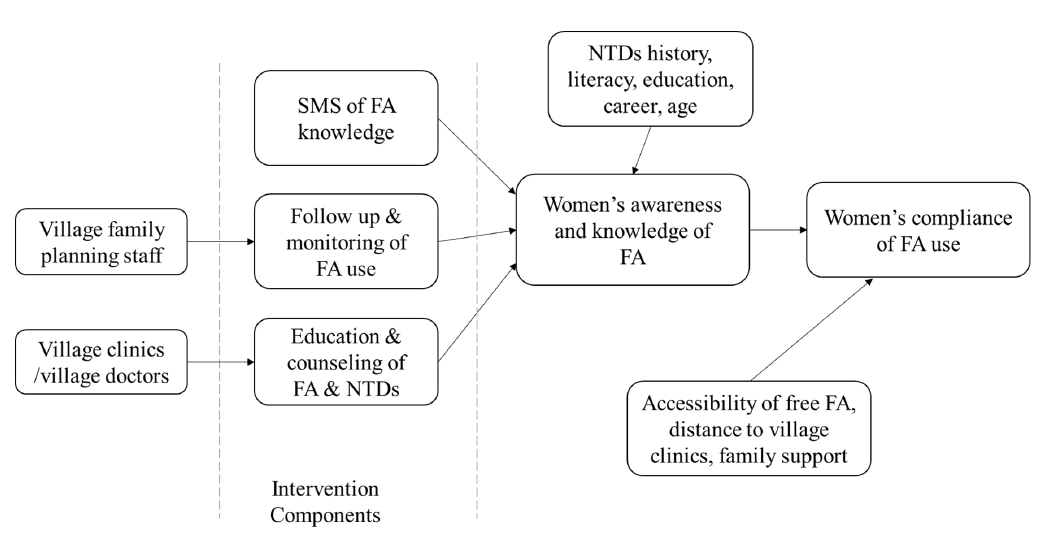
Figure 1. Pathway of the intervention and primary outcome. FA: folic acid; NTD: neural tube defect.